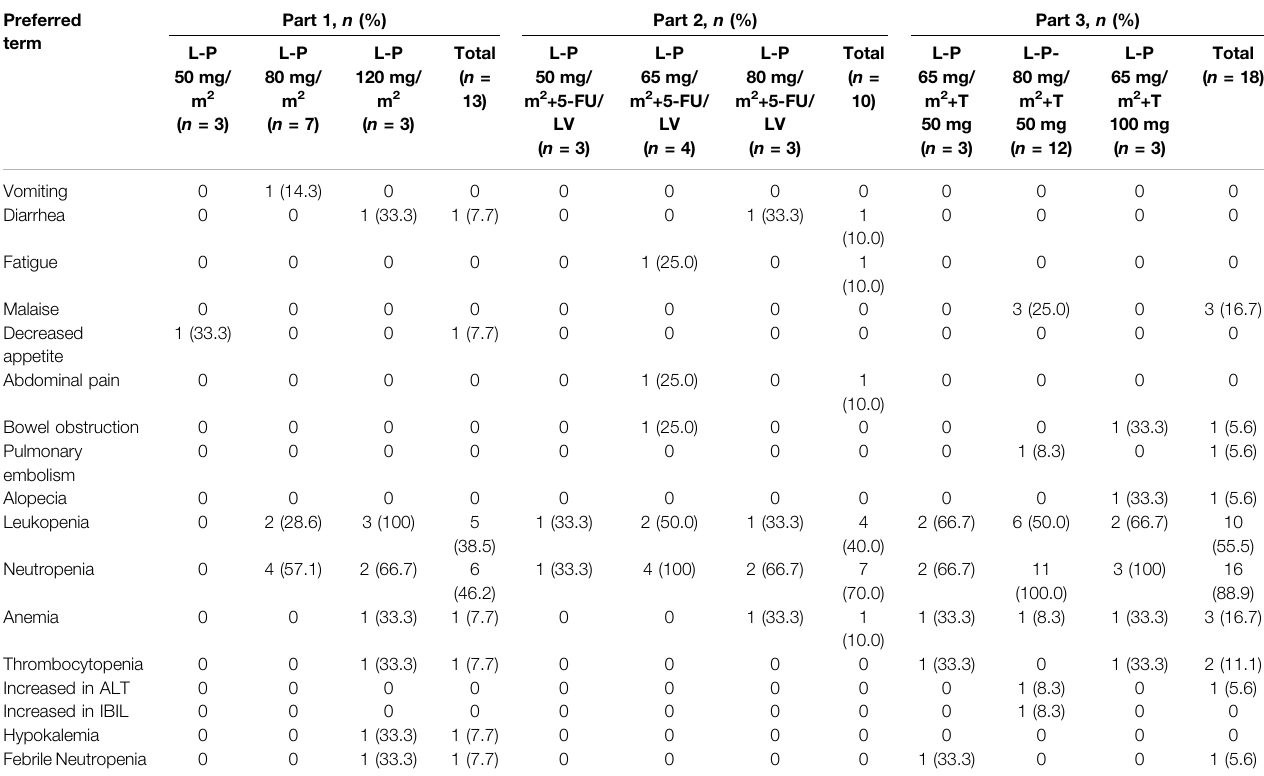
TABLE 4 | Grade 3/4